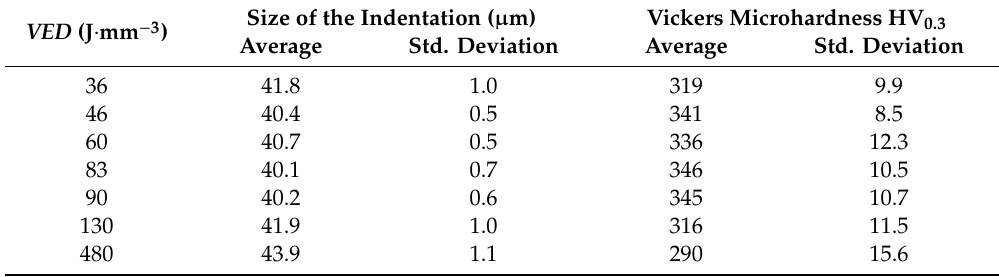
Table 4. Average size of indentation and microhardness with corresponding